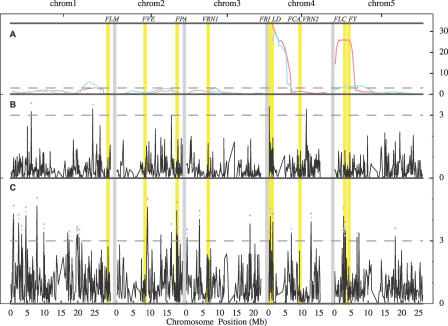
Comparison of Association and Linkage Mapping Results for the Phenotype JIC4WThe position of candidate genes with higher marker density are highlighted in yellow.(A) The QTL LOD scores for two crosses: Col-0 × Lov-1 (pink curve) and Col-0 × Edi-0 (cyan curve). The dashed grey line marks a genome-wide permutation significance level of 5%.(B) Negative log p-values from a genome-wide scan using the Q + K model.(C) Negative log p-values from a genome-wide scan using a naive Kruskal-Wallis approach.(B and C) The dashed grey line marks a nominal significance level of 0.1%, and the colored stars denote associations that should correspond to QTL in the cross displayed using the same color (because the appropriate alleles are segregating; see text).